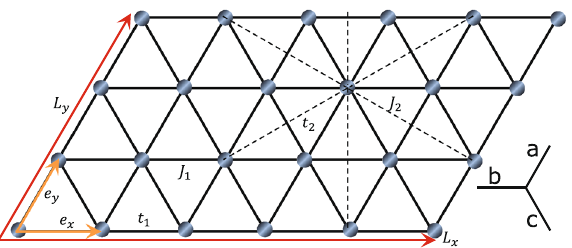
Fig. 1 The t - J model on the triangular lattice. Periodic and open boundary conditions are imposed respectively along the directions speci fi ed by the lattice basis vectors e y and e x . L x and L y are the number of sites in the e x and e y directions. t 1 ( t 2 ) and J 1 ( J 2 ) are hopping integral and spin exchange interactions between NN (NNN) sites. The electrons live at the vertices ( fi lled circles), and a, b, and c denote the three different bonds.